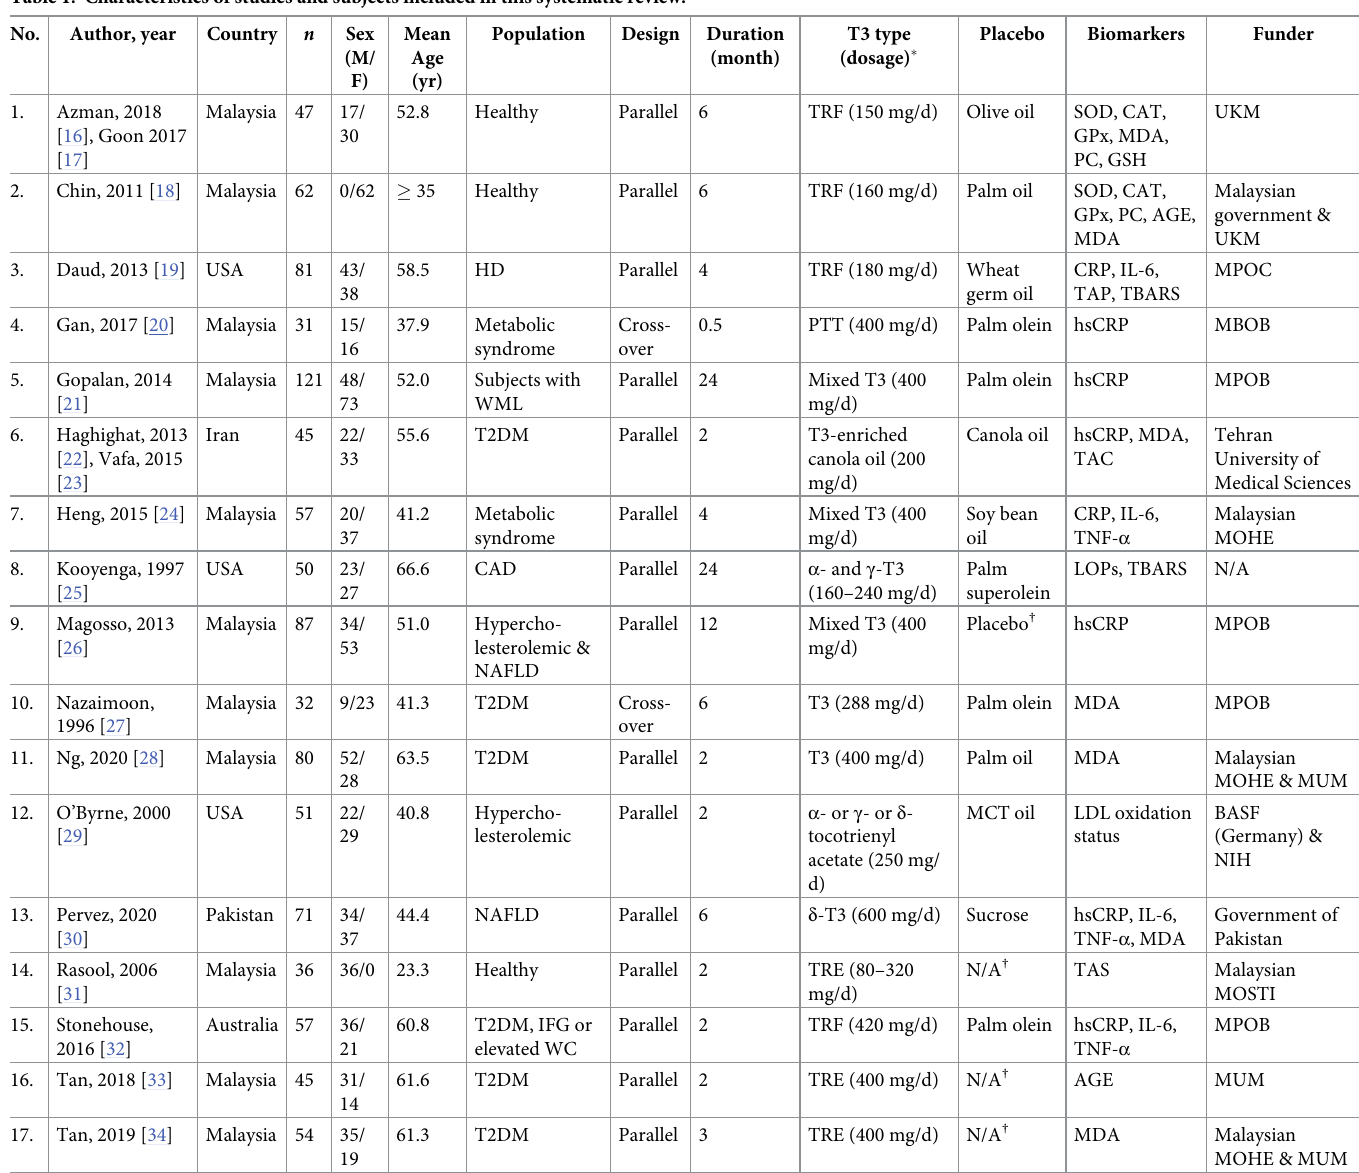
Table 1. Characteristics of studies and subjects included in this systematic